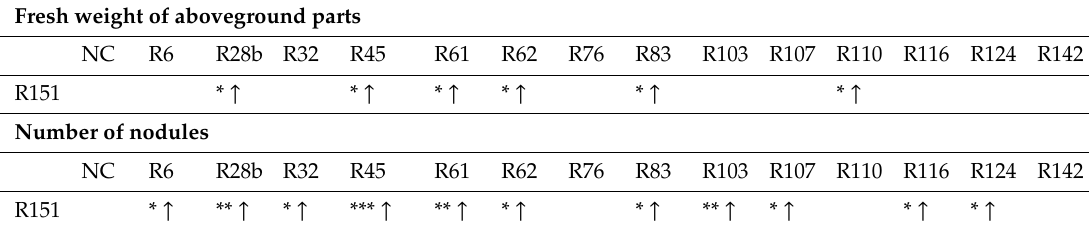
Table 4. Statistical analysis of results of comparison of underground parts weight, aboveground parts weight, and nodules number of pea per plant between experimental groups; * p < 0.05, ** p <